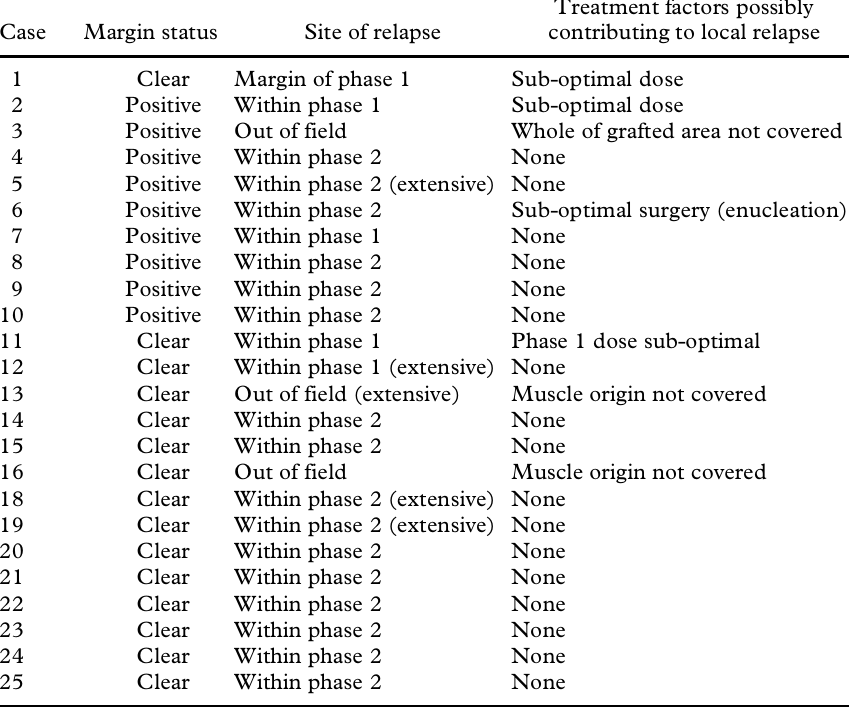
Table 4. Detail of